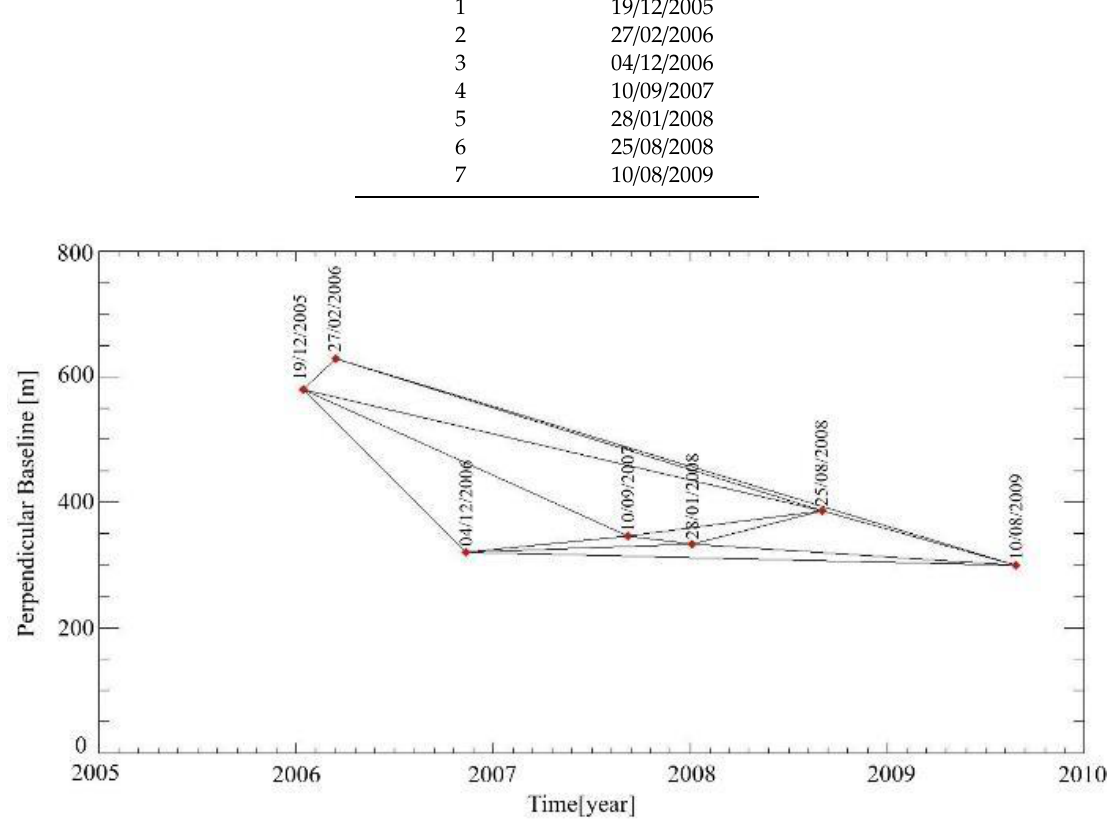
Figure 15. Interferometric SAR data pair distribution of the used ASAR / Envisat acquisitions related to the Afar depression area. Red points and black lines indicate the SAR data and the interferograms, respectively.